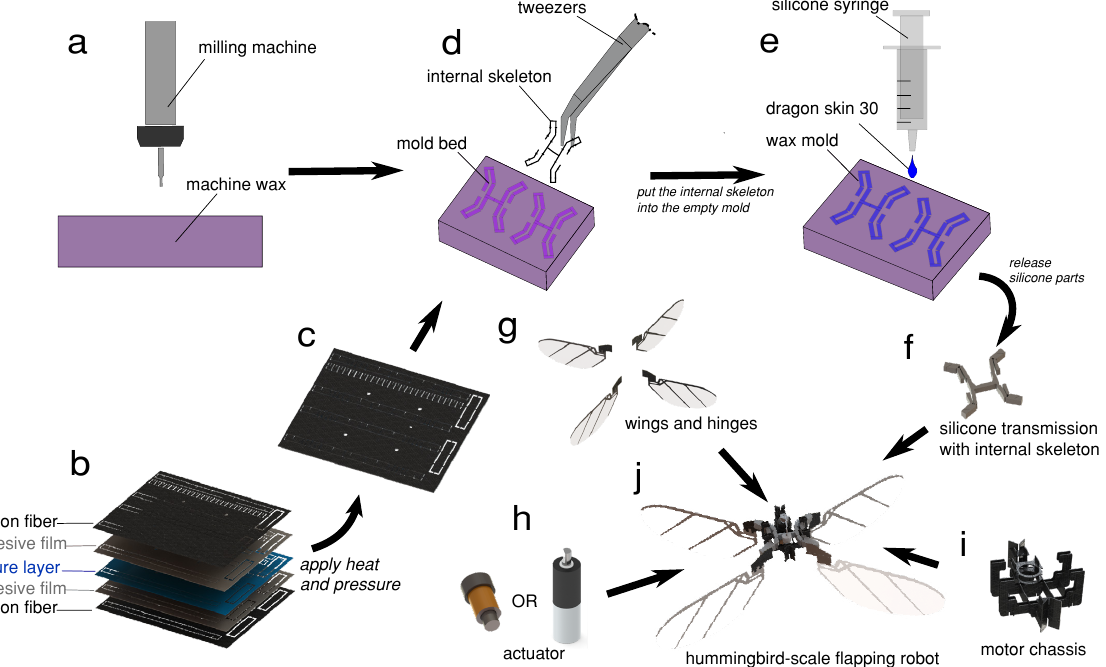
Figure 2. Overview of the manufacturing process. ( a ) The wax mold for the compliant transmission was machined using a 1/32 (cid:48)(cid:48) flat end mill in an Othermill micro-milling machine. ( b ) The skeleton of the transmission is a laminate constructed from a 5-layer stack of CF, adhesive, and thin, flexible polymer. ( c ) We apply heat and pressure to fuse the laminate, pop out the skeleton, and fold it into the proper shape. ( d ) The CF internal skeleton was placed into the mold bed, held in place by small horizontal tabs to prevent misalignment. ( e ) Mold was filled with silicone (Dragon Skin 30, Smooth- On), using a syringe to ensure an even fill. After setting completely, the compliant transmission ( f ) was assembled with the wings ( g ), actuator ( h ), and motor chassis ( i ) into the completed FWMAV ( j